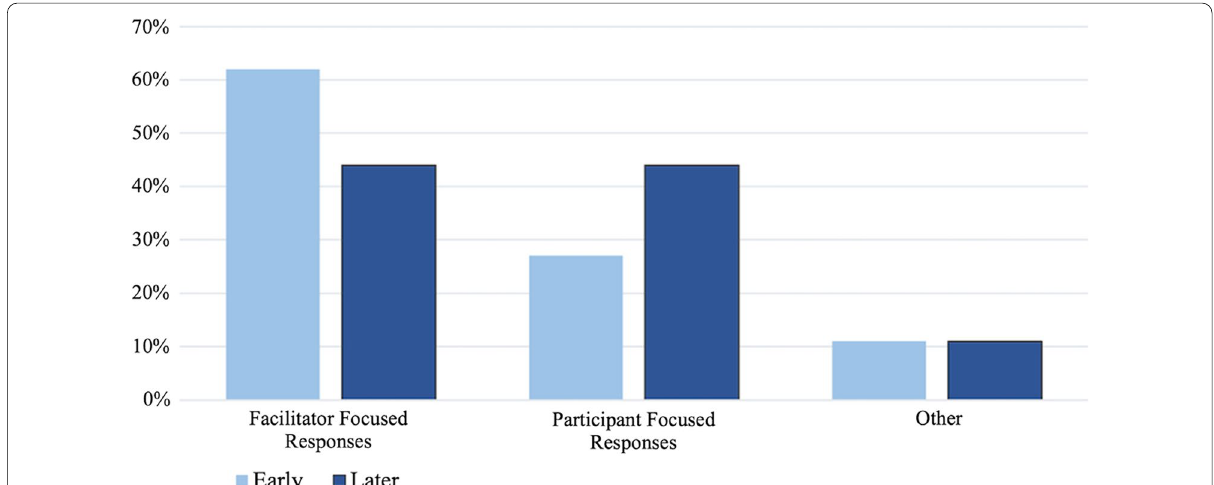
Fig. 4 Total Participant Focused, Facilitator Focused, and Other responses in early and later meetings. For the 5 early meetings, there was an average of 23 responses per meeting (averaging roughly 15 facilitator focused, 7 participant focused, and 1 other) and for the five later meetings there was an average of 20 responses per meeting (averaging roughly 9 facilitator focused, 9 participant focused, and 2 other)